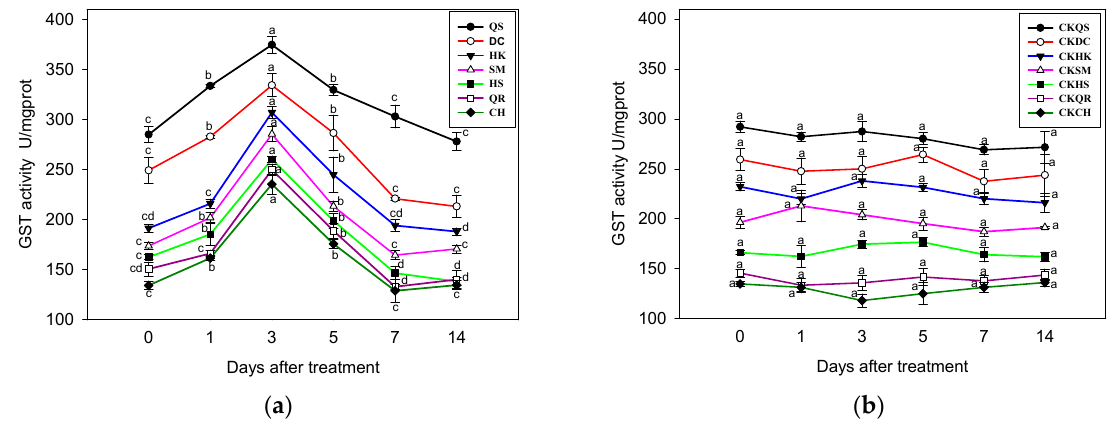
Figure 5. The GST activity of E. crus ‐ galli under 50 mM NaCl treatment. The GST activity of E. crus ‐ galli with 50 mM NaCl ( a ) and without NaCl treatment ( b ). Lowercase letters are expressed as least square means ± standard error ( p < 0.05).